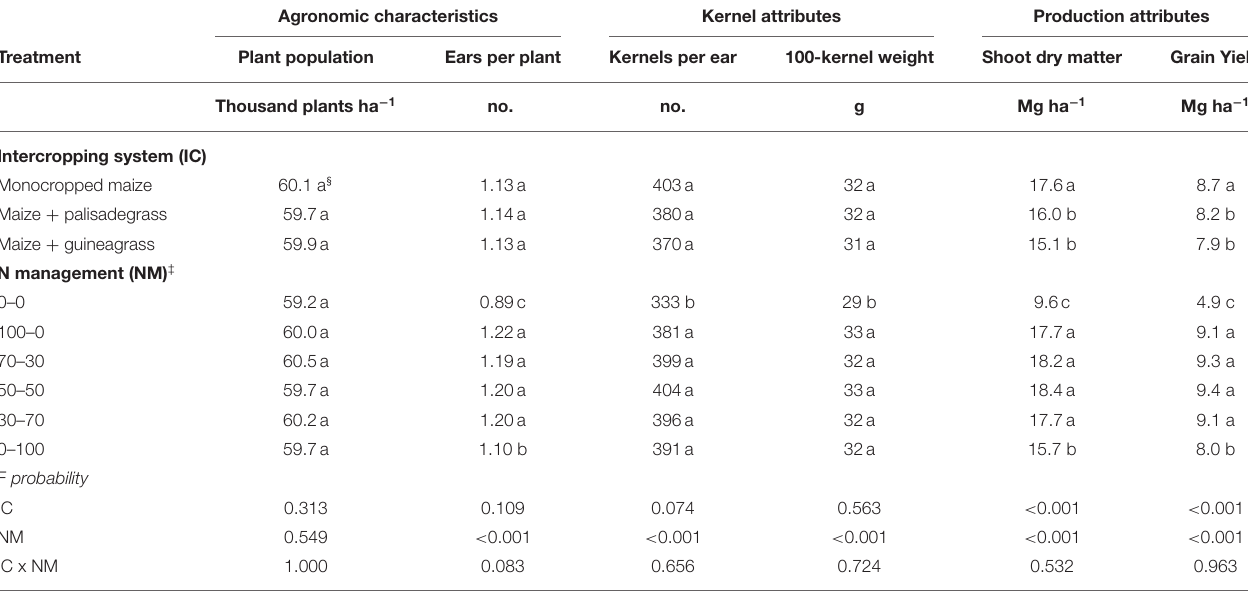
TABLE 2 | Agronomic characteristics (plant population and number of ears per plant), kernels attributes (number of kernels per ear and 100-kernel weight) and production attributes (shoot dry matter and grain yield) of maize as affected by intercropping system, N management in the three growing